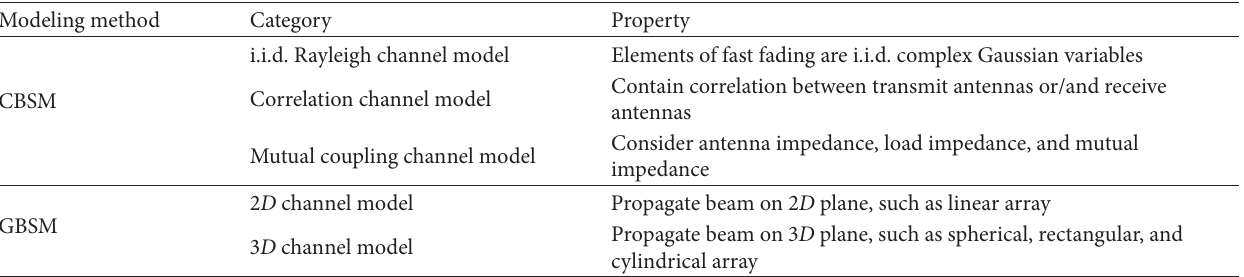
Table 3: Channel models of massive